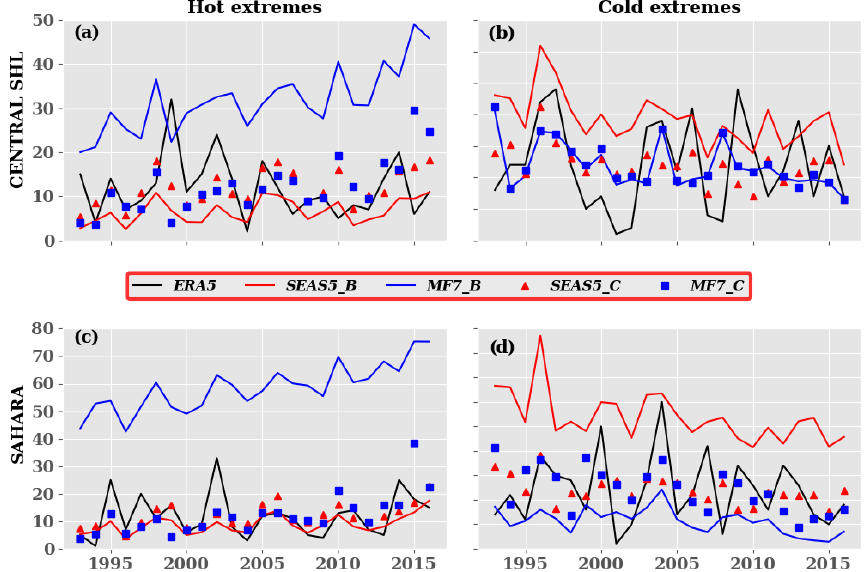
Figure 10. Interannual variability in the SHL extremes over the (a, b) central SHL and (c, d) Sahara during the JJAS period from 1993 to 2016. SEAS5_C and MF7_C refer to corrected forecasts with the CDF-t method, and SEAS5_B and MF7_B represent raw model forecasts. The x axis indicates the time (year) and y axis the number of extremes registered for each year. Hot extremes are events occurring above the 90th percentile, and cold extremes are associated with events below the 10th percentile.